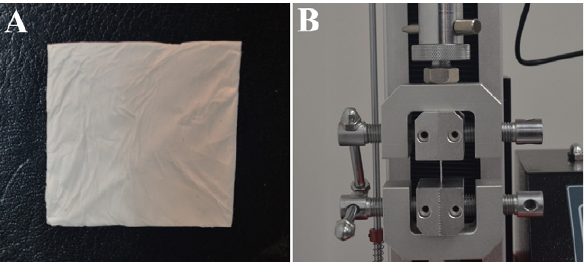
Figure 2: Preparation and mechanical test of PAN nanofiber mem- brane: A) Fabricated aligned PAN nanofiber membrane; B) Tensile experiment procedure.